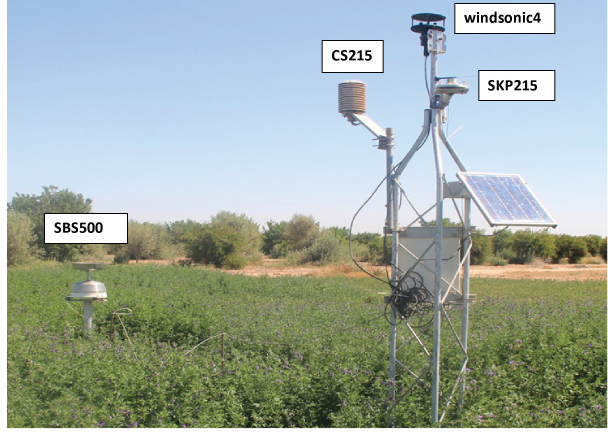
Figure 7. Automatic weather station installed in an alfalfa field near F1, F2 and